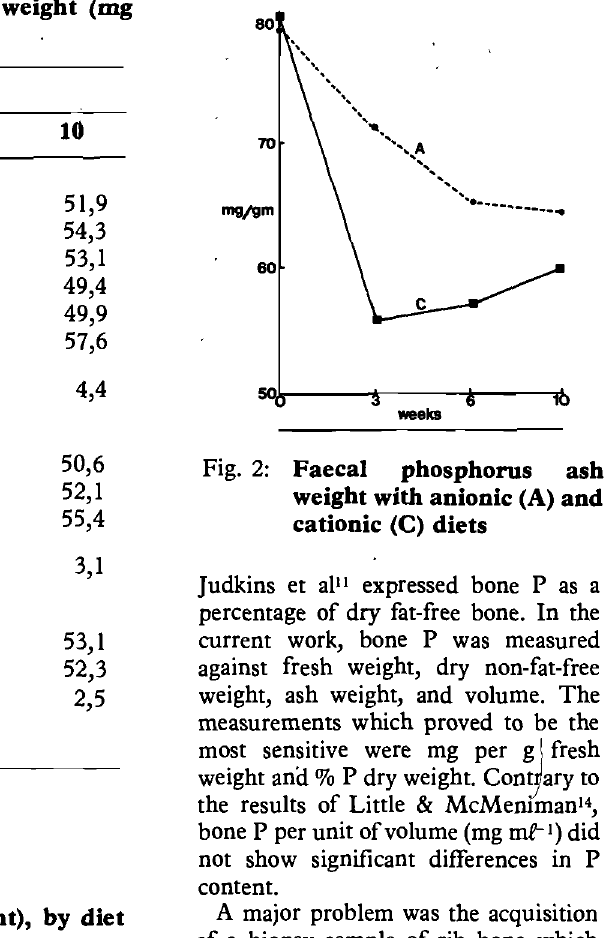
Table 3: Least squares mean bone phosphorus (% dry weight), by diet and week throughout the trial